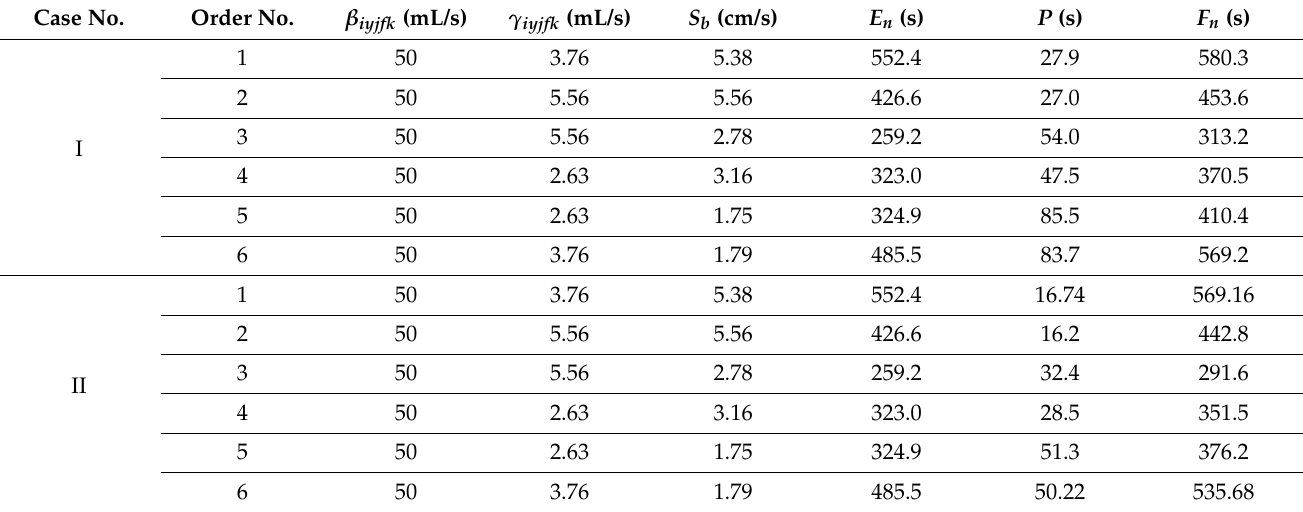
Table 4. Optimal solutions for Case-I and